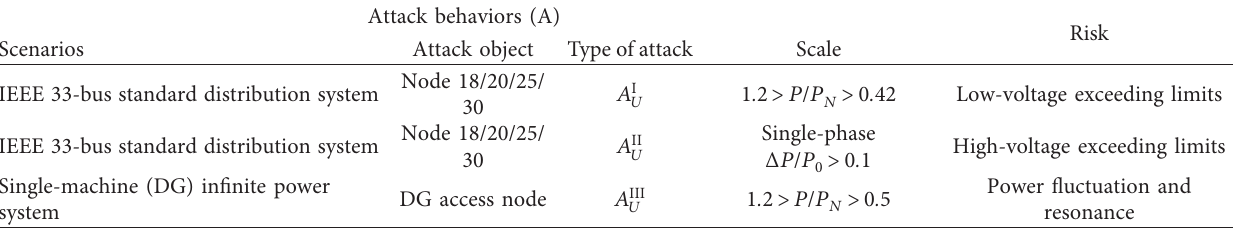
Table 1: Distribution network control model with